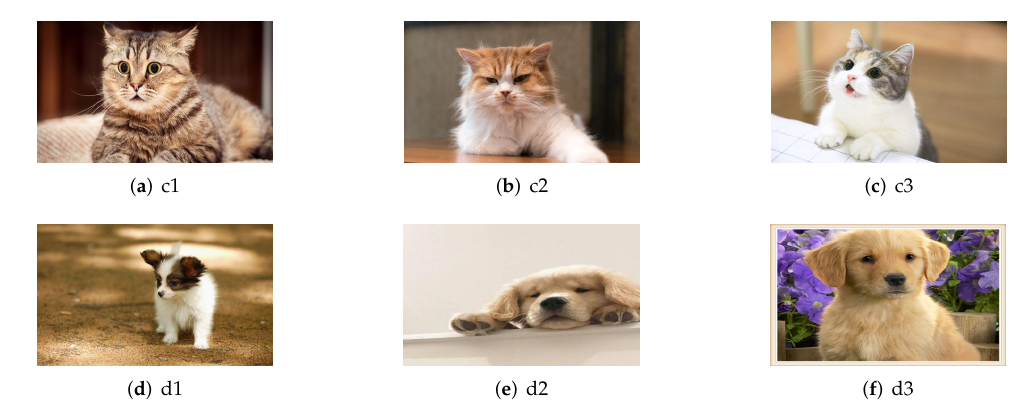
Figure A1. Three cats: c1, c2, c3 ( a – c ); three dogs: d1, d2, d3 ( d – f